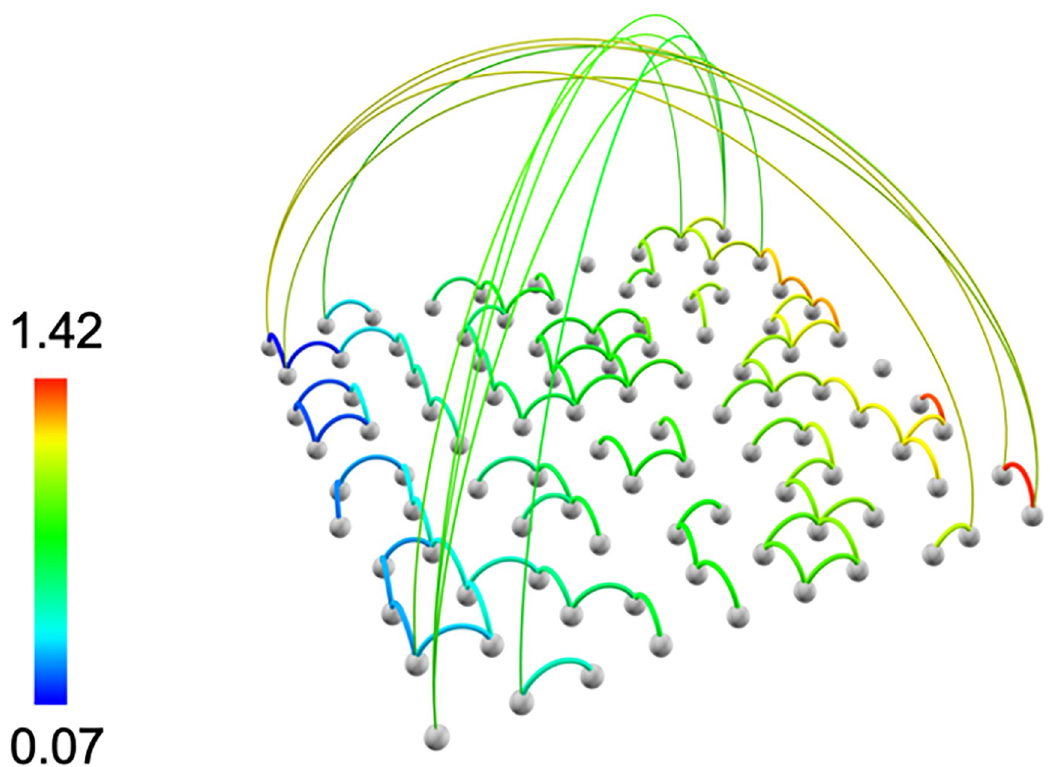
Fig 3. Height, radius and color of the links. The height of the links is proportional to the internode distance d ij . The radius is instead inversely proportional to d . The color of the links code for the weight of the connections. This synthetic network has been ij visualized with Vizaj using a Circle shape for the links.